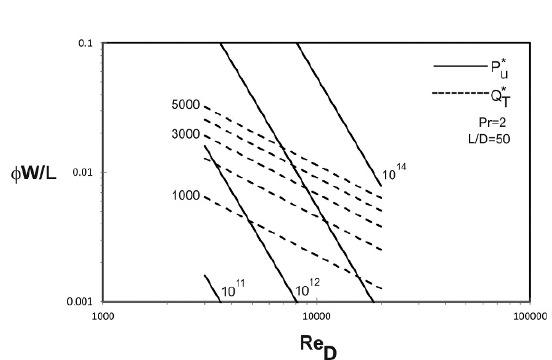
Figure 14. Φ W/L groupversustheReynoldsnumberfordifferentdi- mensionless heat transfer conductance and fluid pump- ing power (turbulent regime and prescribed wall temper- ature boundary)